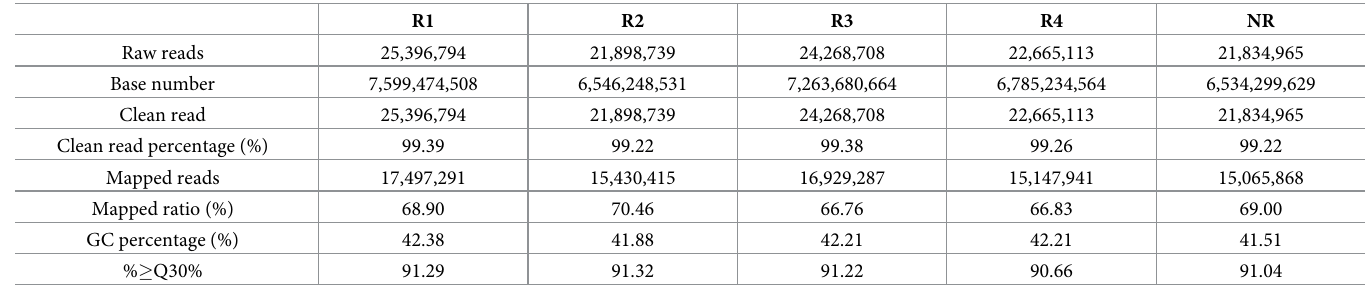
Table 1. Summary statistics of clean reads in the five tissues of the Caucasian clover